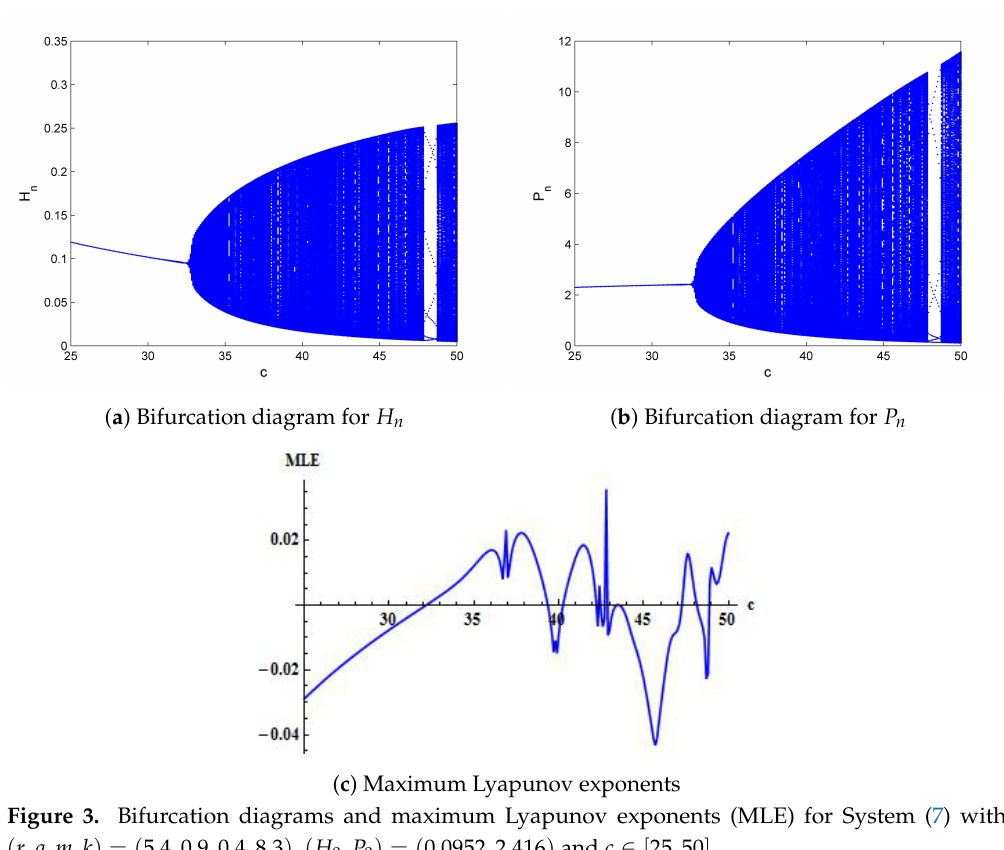
Figure 3. Bifurcation diagrams and maximum Lyapunov exponents (MLE) for System (7) with ( r , q , m , k ) = ( 5.4,0.9,0.4,8.3 ) , ( H ) = ( 0.0952,2.416 ) and c ∈ [ 25,50 ] 0 , P 0